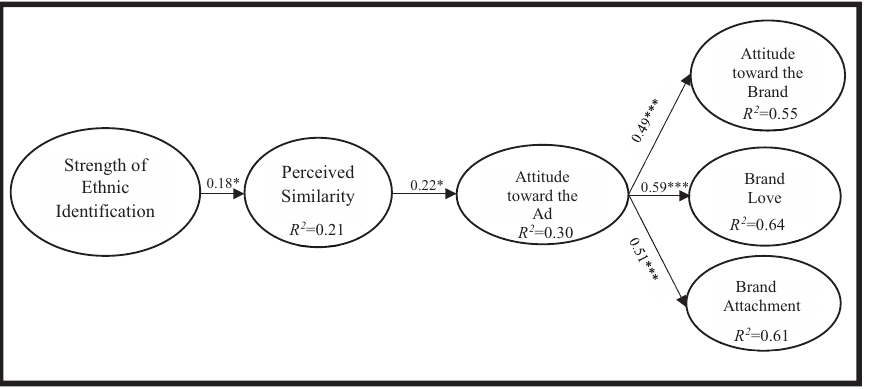
Figure 1. Study 1 – conceptual model of the antecedents of